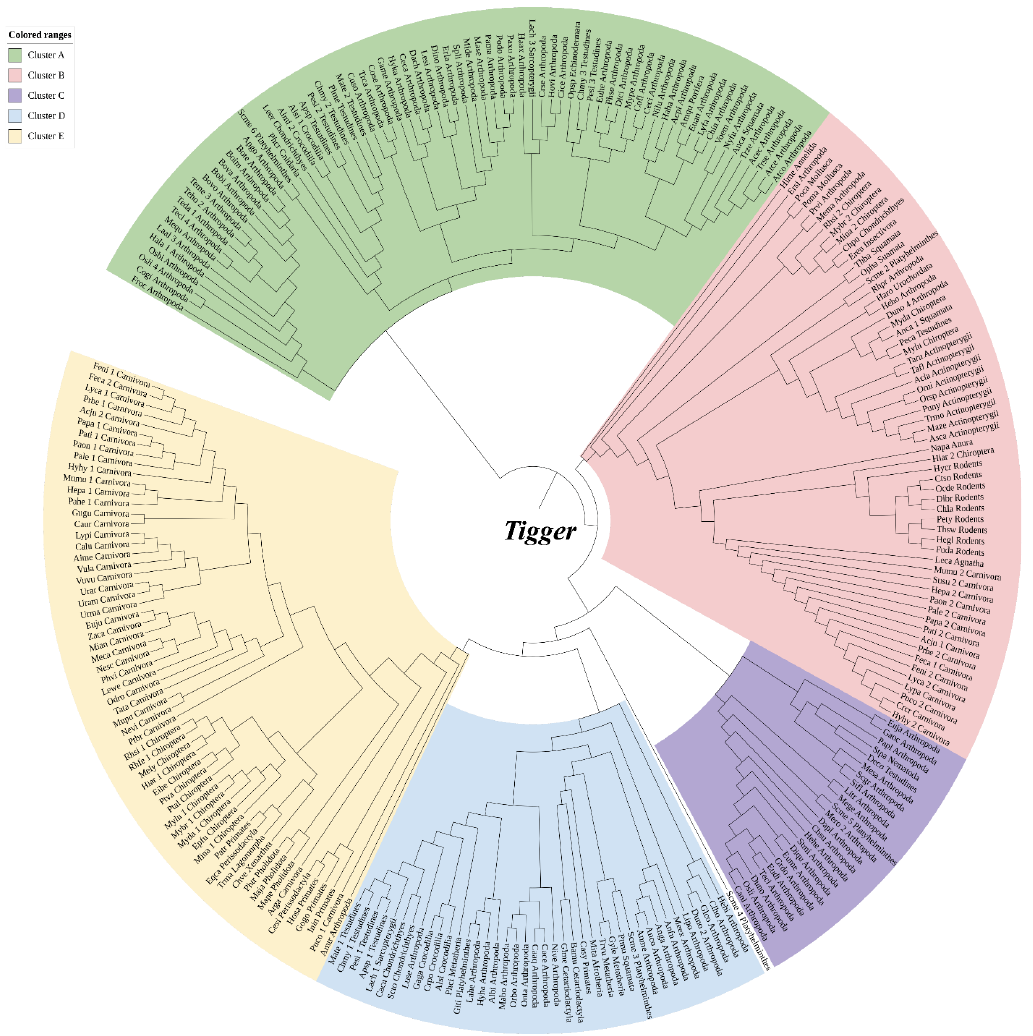
Figure 2. Intrafamily diversity of Tigger elements in the animal kingdom; each colored branch rep- resents a phylogenetic tree cluster.